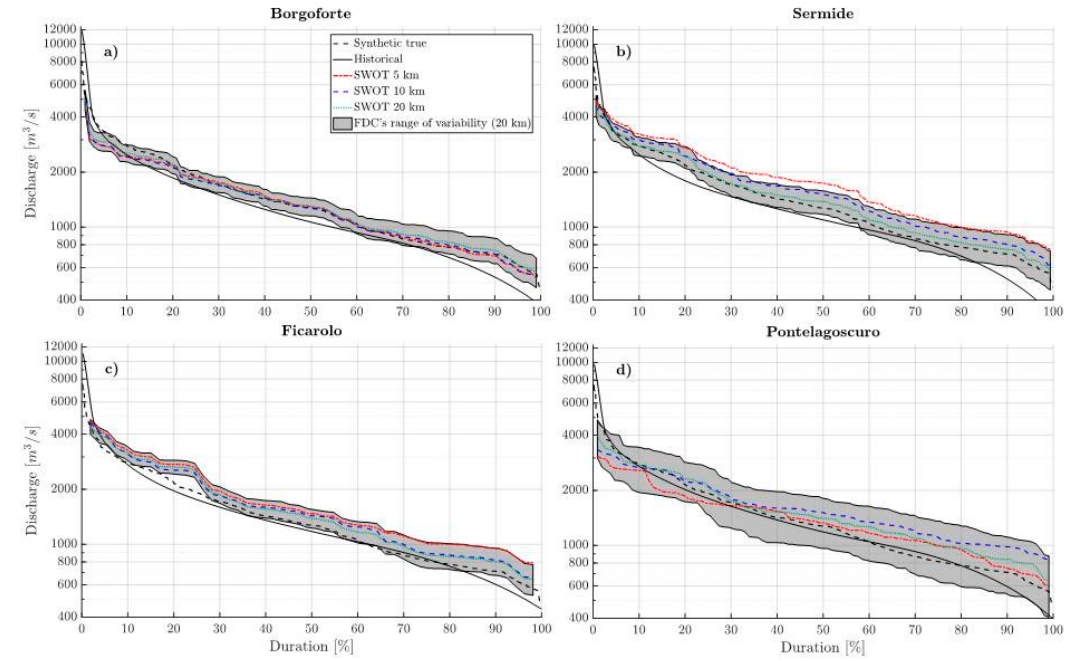
Figure 9. FDCs at the gauging stations for the three-year period based on observed daily data (black dashed line) and estimated from SWOT-like observations, considering different river discretizations; grey area represents the 90% confidence interval of streamflow estimation with ∆ x = 20 km; black solid lines show FDCs based on historical data recorded at the gauging stations.